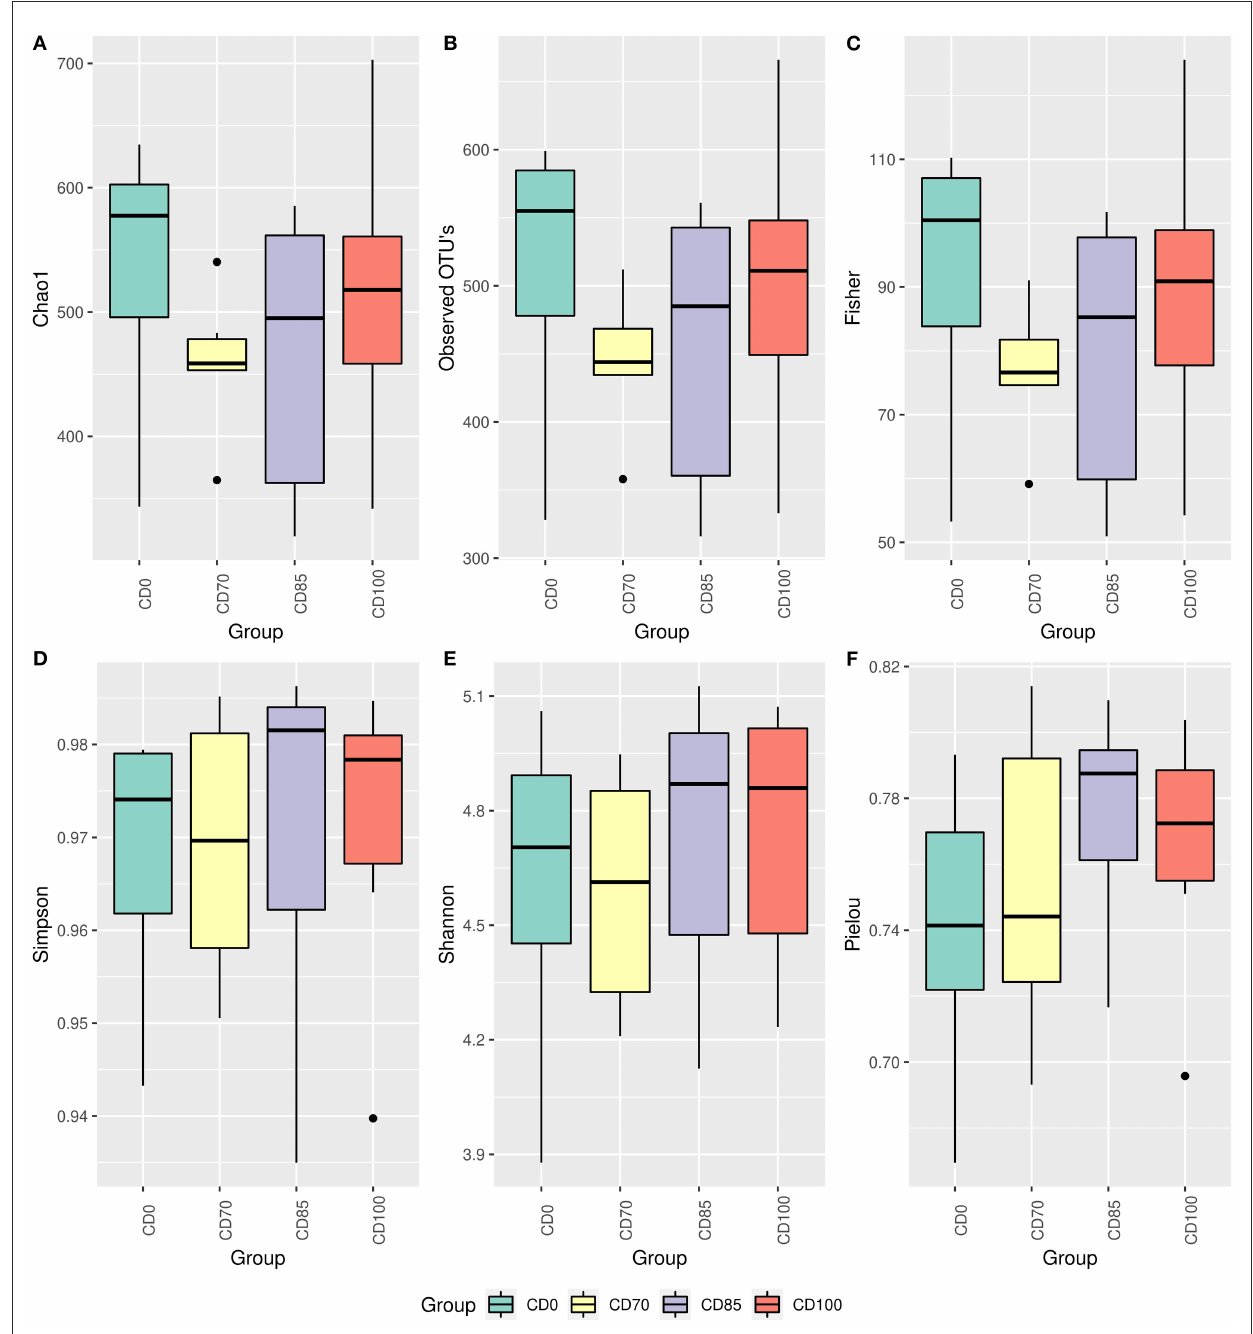
FIGURE1 Alpha diversity estimated by parameters Chao1 (A) , observed OTUs (B) , Fisher (C) , Simpson (D) , Shannon (E) , and Pielou (F) in finisher pigs fed 1 of 4 dietary treatments: a control diet containing isolated phytase and xylanase valued at 40 kcal of ME/kg (CD0), CD0 + β -mannanase (0.3 g/kg valued at 30 kcal of ME/kg) (CD70), CD0 + β -mannanase (0.3 g/kg valued at 45 kcal of ME/kg) (CD85), and CD0 + β -mannanase (0.3 g/kg valued at 60 kcal of ME/kg) (CD100). Data are averages of 6 pigs per dietary treatment.